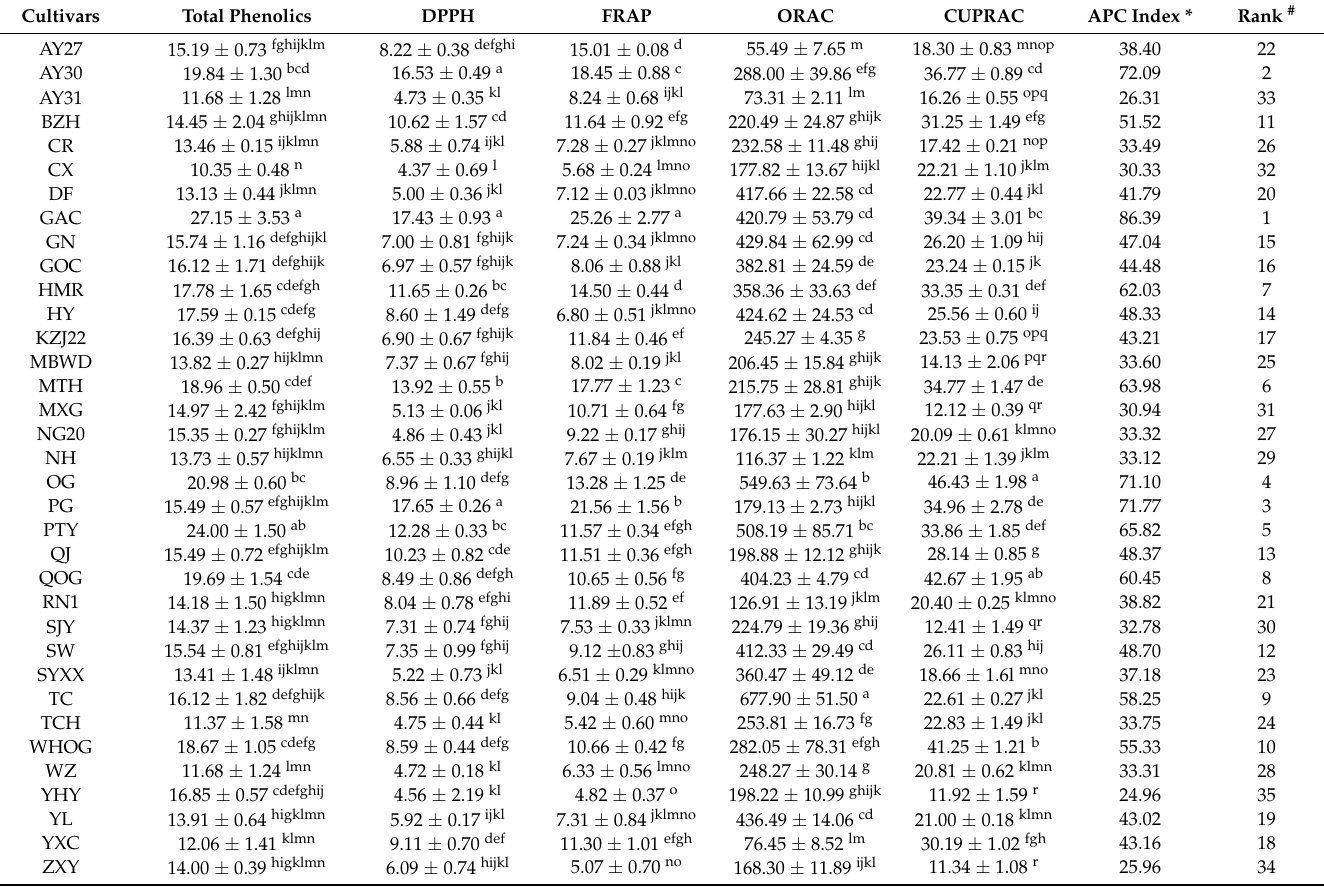
Table 3. Total phenolics and antioxidant properties of citrus fruit albedo of 35